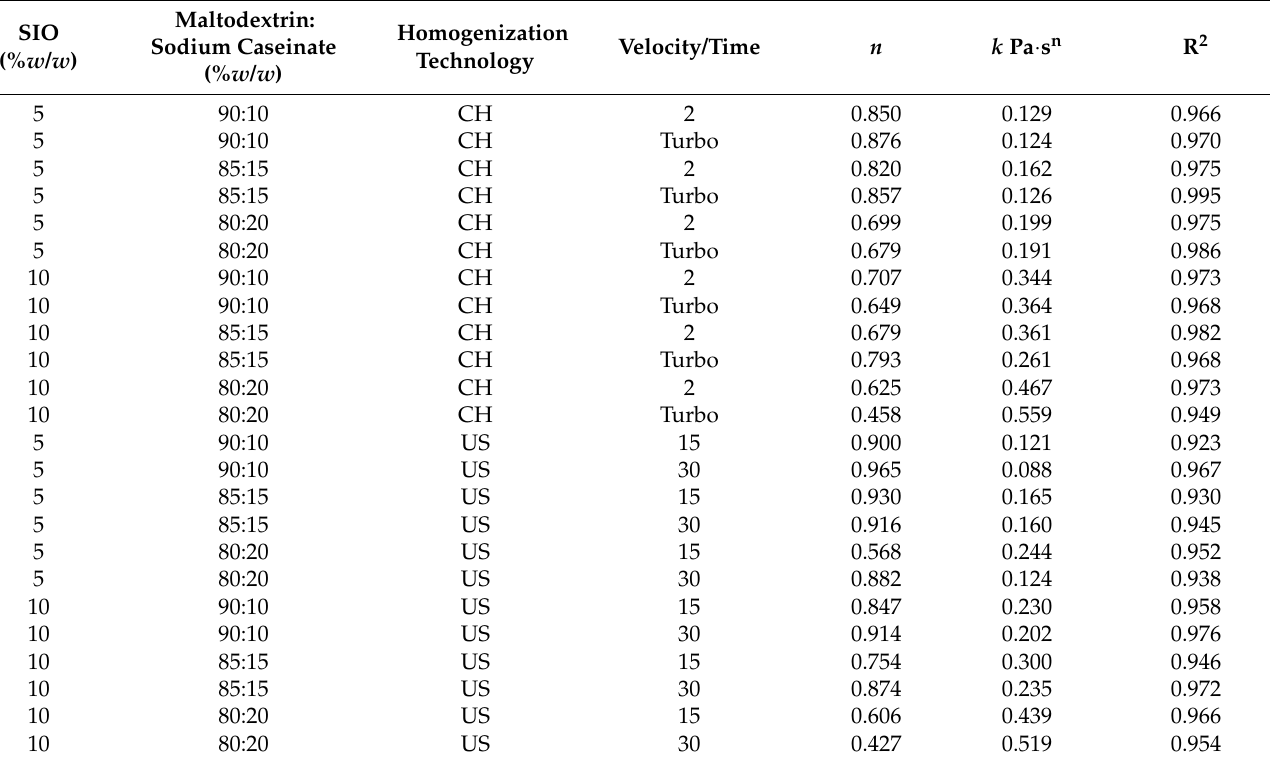
Table 3. Flow index ( n ), consistency index (k), and R 2 for sacha inchi seed oil emulsions prepared with conventional and ultrasound probe